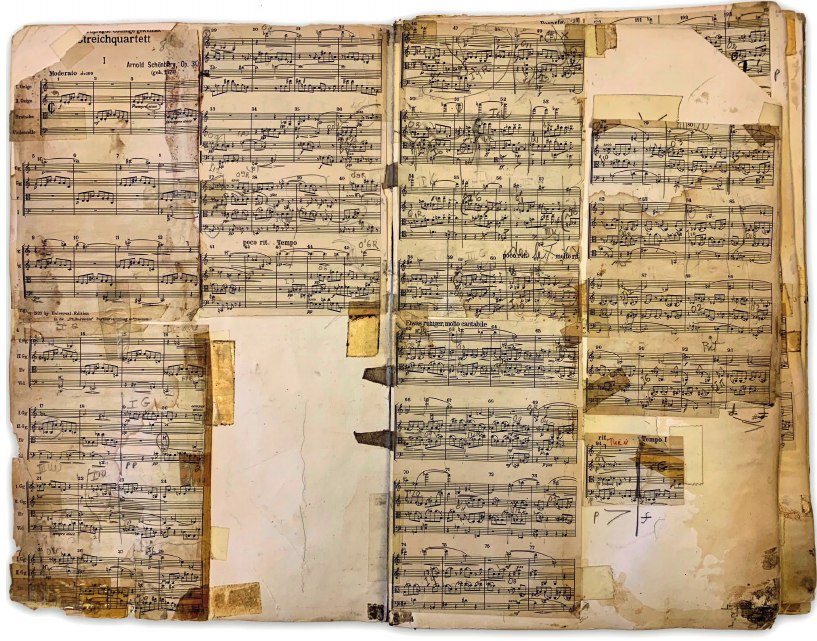
Fig. 2 Kolisch’s part-score of Schönberg’s String Quartet no. 3, op. 30. Rudolf Kolisch Papers, Houghton Library, Harvard University, bMS Mus 195 (1952), fol.